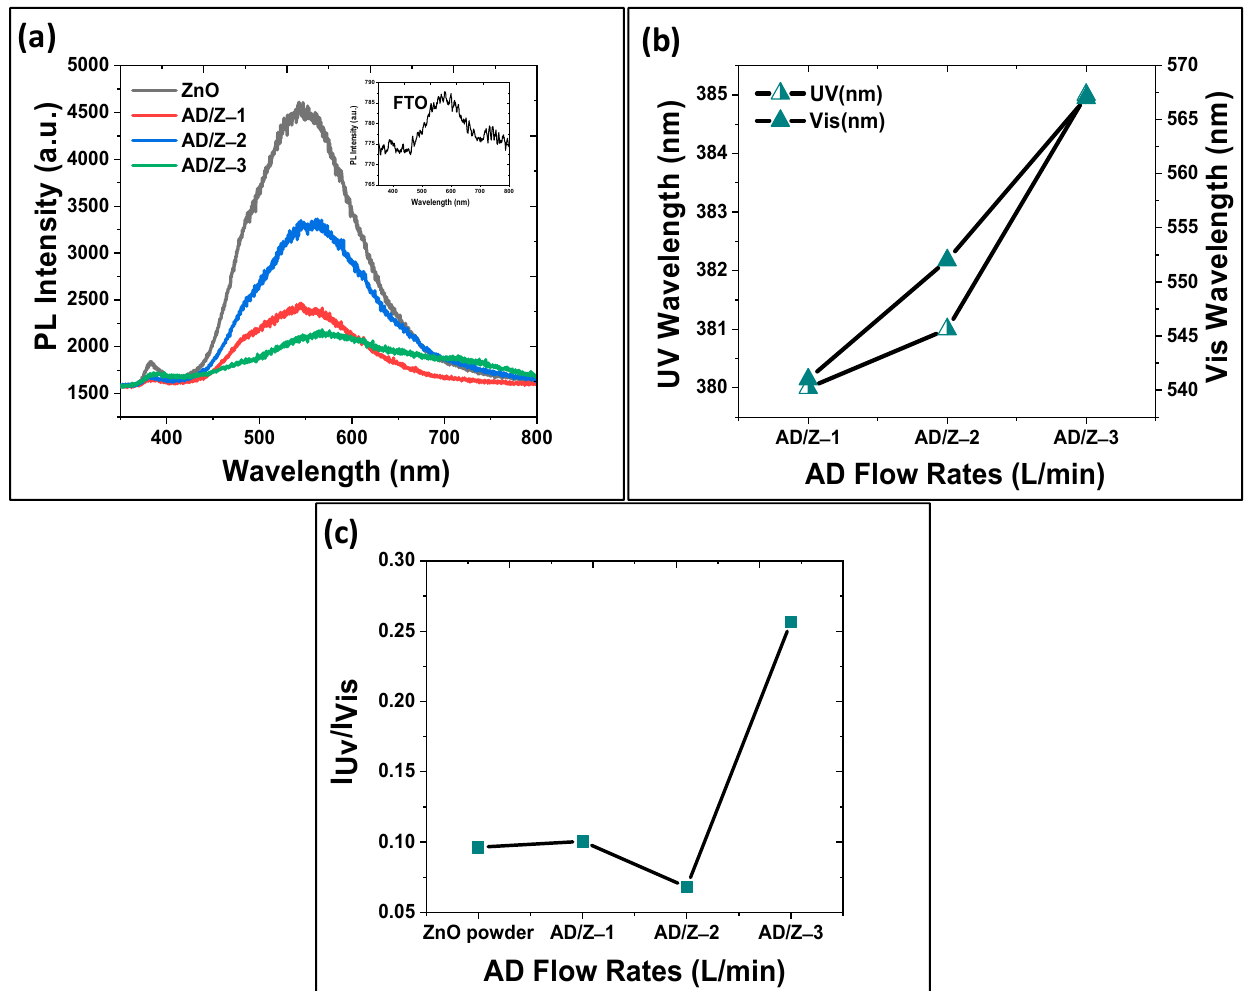
Figure 7. ( a ) RTPL spectra. ( b ) Maximum peak of the UV and visible emissions. ( c ) Ratio of the UV– Vis emissions of the AD/ZnO films deposited at different AD flow rates.